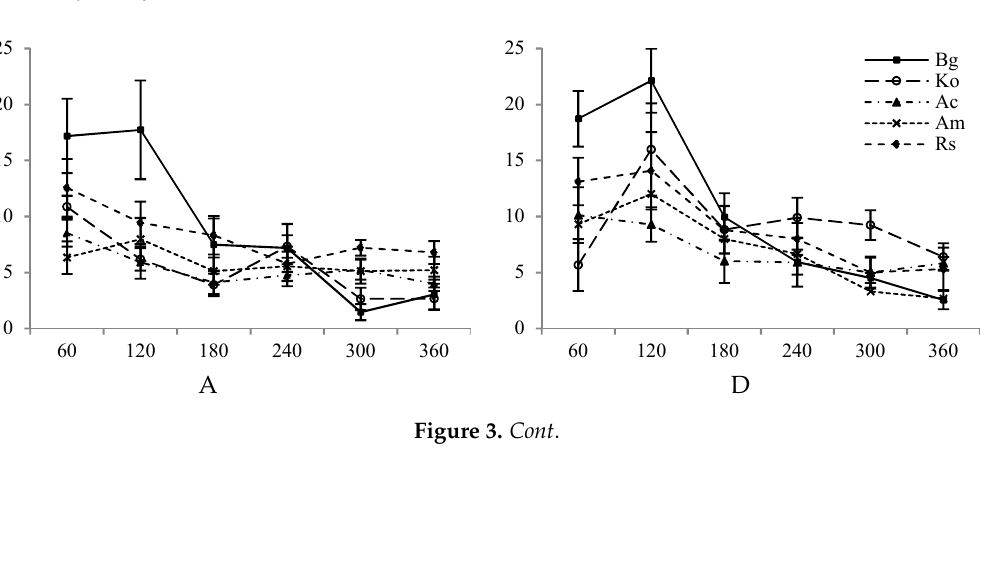
Figure. 2. The number of seedlings of the five mangrove species surviving ( Bg = Bruguiera gymnorrhiza , Ac = Aegiceras corniculatum , Ko = Kandelia obovata, Rs = Rhizophora stylosa, Am = Avicennia marina ) ( A ) 30% canopy closure and high intertidal elevation, ( B ) 60% canopy closure and high intertidal elevation ( C ) 90% canopy closure and high intertidal elevation, ( D ) 30% canopy closure and low intertidal elevation, ( E ) 60% canopy closure and low intertidal elevation, ( F ) 90% canopy closure and low intertidal